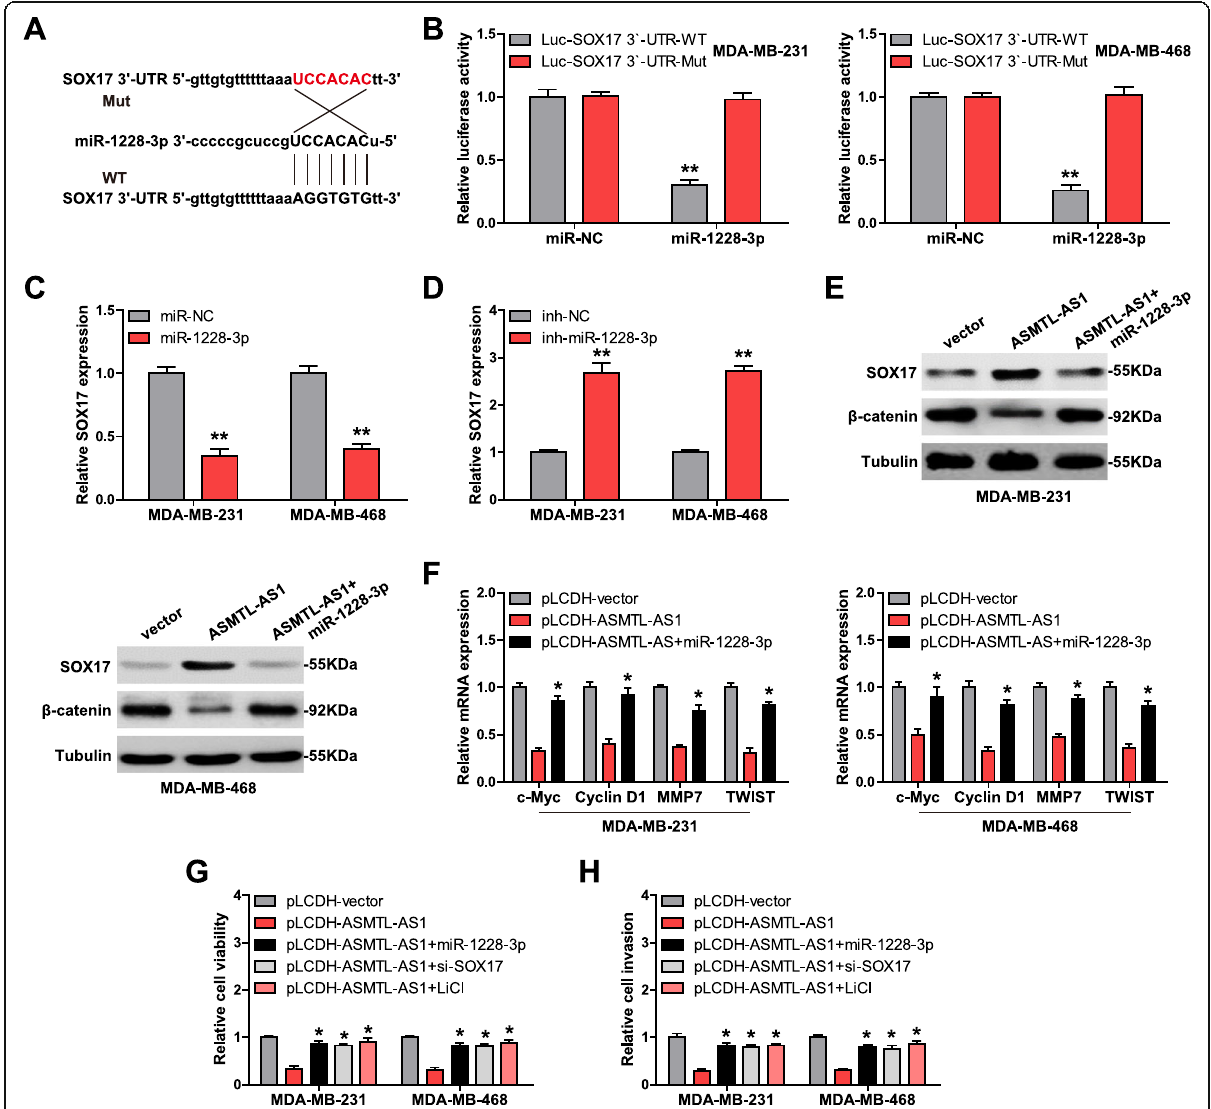
Fig. 4 ASMTL-AS1 regulates the miR-1228-3p/SOX17/ β -catenin axis. a , b . The binding site between SOX17 3`-UTR and miR-1228-3p, followed by mutation and luciferase reporter assay. c , d . qRT-PCR analysis of SOX17 mRNA level after alteration of miR-1228-3p expression. e . Western blotting testing SOX17 and β -catenin protein levels in ASMTL-AS1-overexpressing cells transfected with miR-1228-3p mimics. f . qRT-PCR analysis of β - catenin targets in ASMTL-AS1-overexpressing cells transfected with miR-1228-3p mimics. g , h . CCK-8 and Transwell assays respectively testing cell viability and invasion in ASMTL-AS1- overexpressing cells transfected with miR-1228-3p mimics, SOX17 siRNA or treated with LiCl, a specific activator of Wnt/ β -catenin pathway. * P < 0.05, ** P <